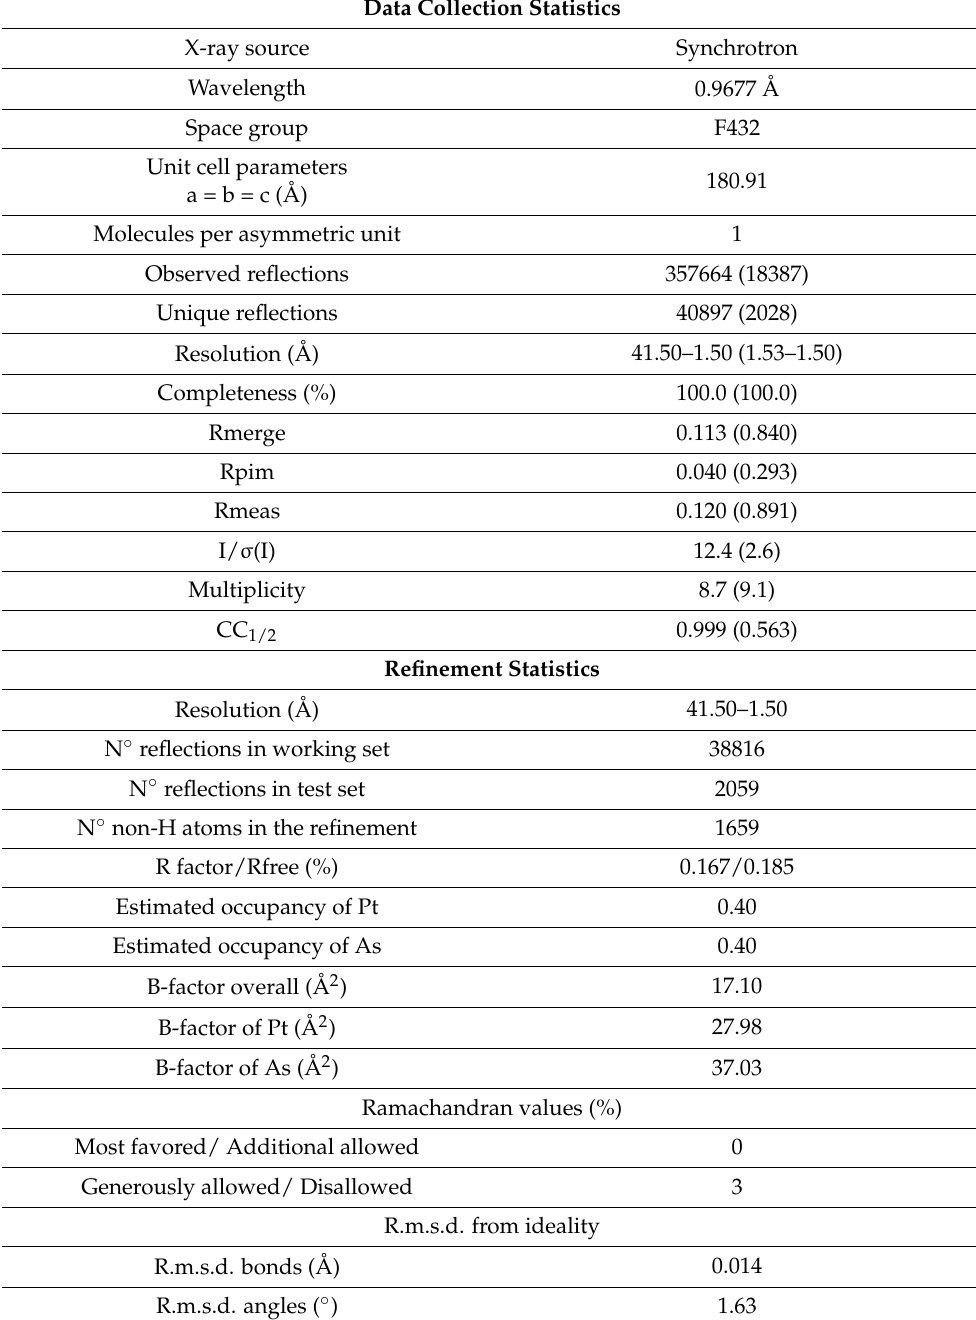
Table 2. Data collection and refinement statistics for AP-1-encapsulated